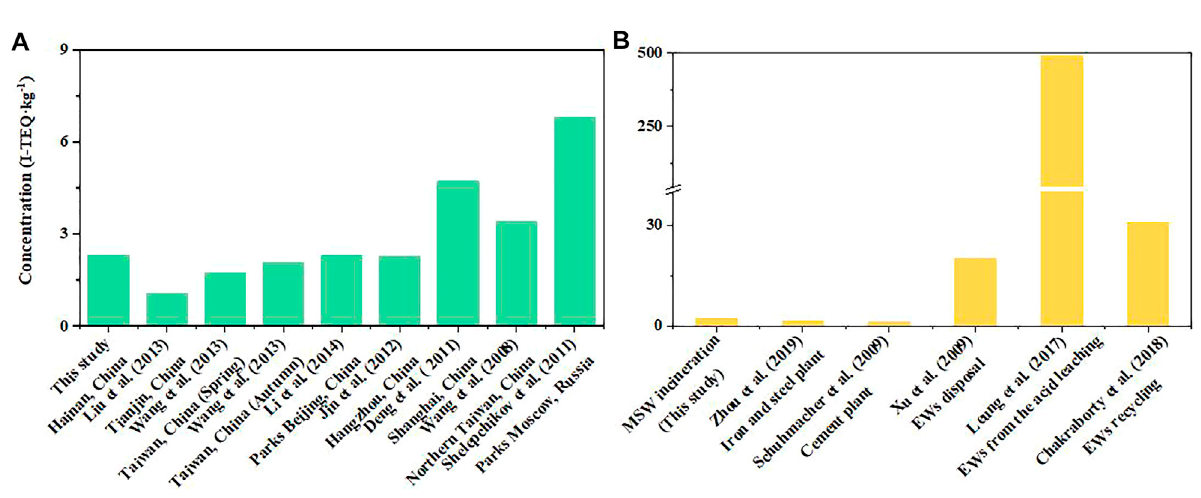
FIGURE 4 ComparativeanalysisoftheliteratureontheI-TEQvalues(unit:ngI-TEQ · kg − 1 )ofPCDD/FsfromMSWincineratoremissionsource (A) andother emission sources (B)